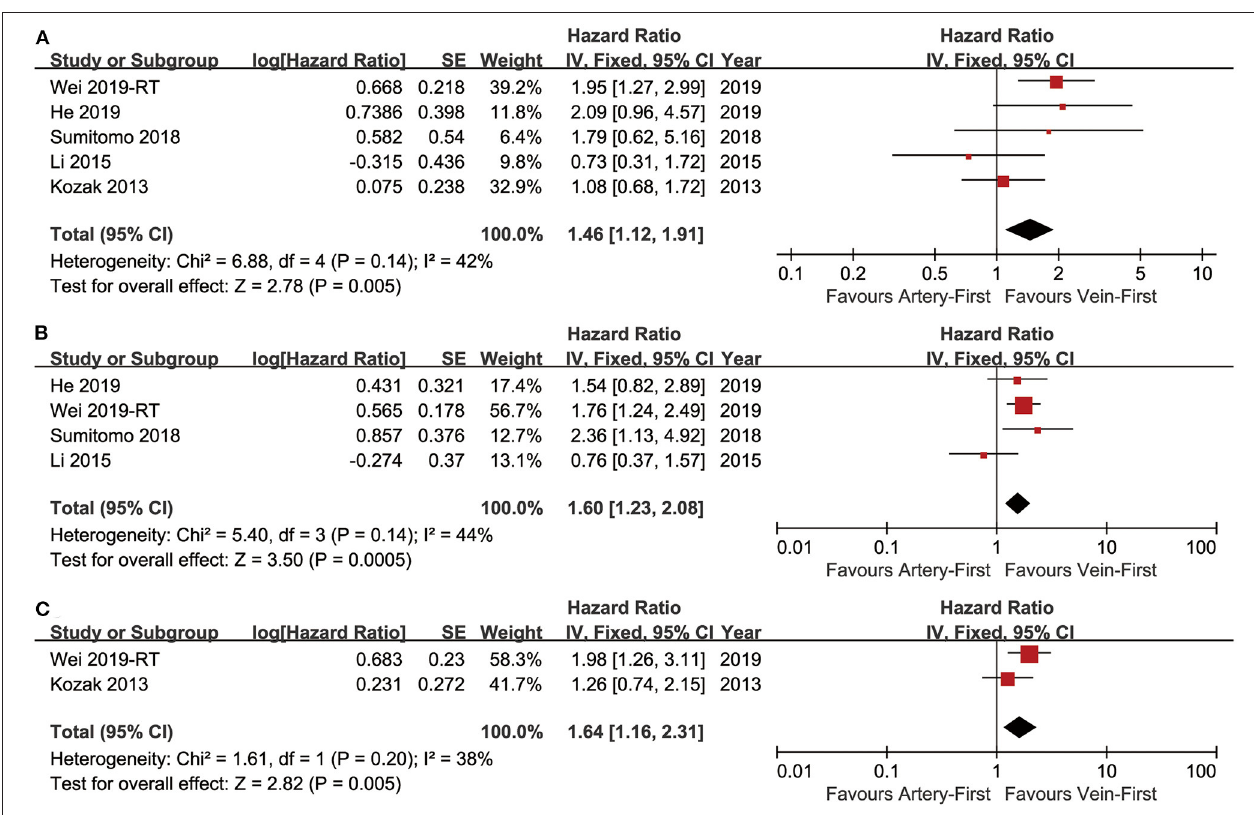
FIGURE 2 | Forest plots of OS (A) , DFS (B) , and LCSS (C) associated with Vein-first vs. Artery-first.